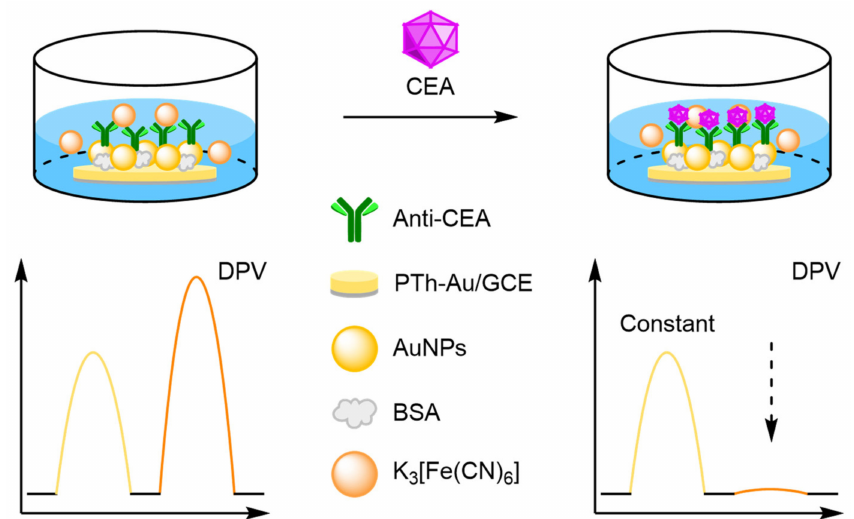
Figure 26. Schematic representation of a modified electrode for the detection of carcinoembryonic antigen